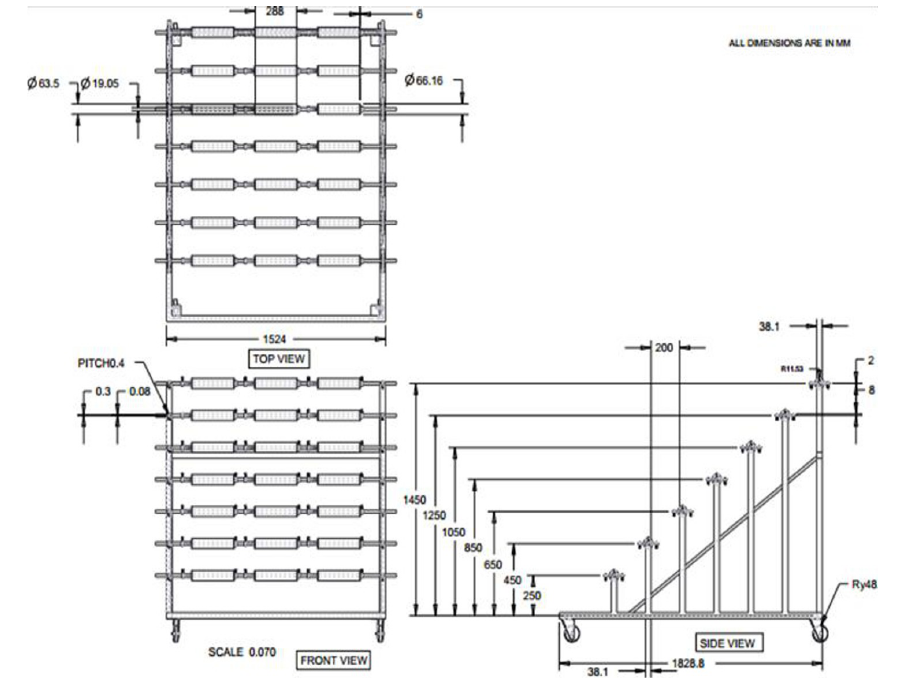
FIG.2 TWO-DIMENSIONAL VIEWS OF WARP CREEL